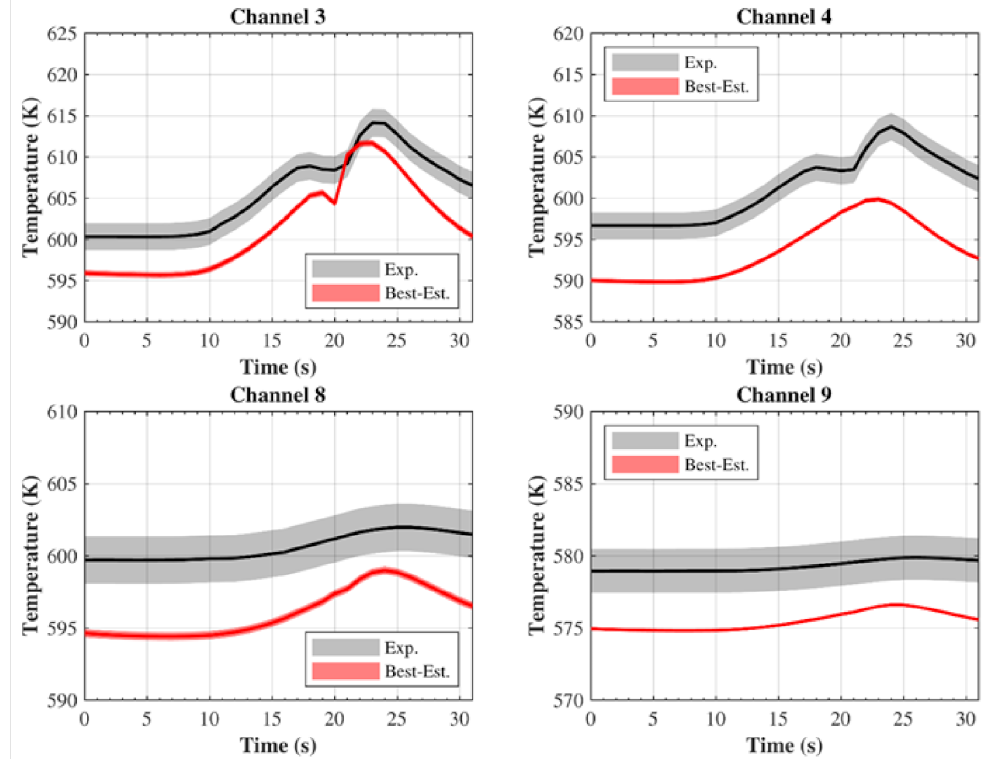
Figure 11. Outlet coolant temperature—300 kW/m 2 , 0% valve opening